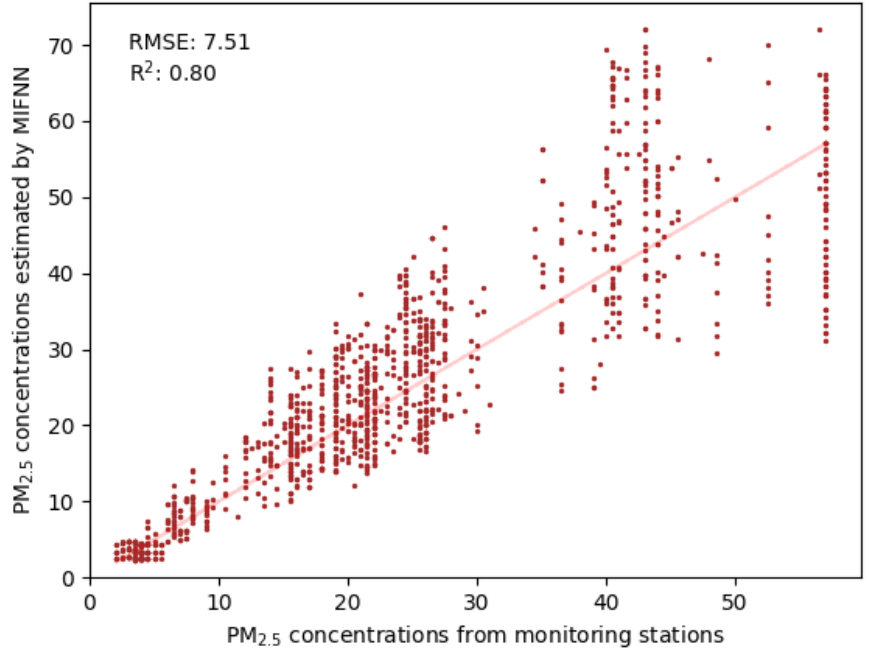
Figure 10. Correlation between PM 2.5 concentrations measured by ground-based monitoring stations and those estimated by the MIFNN model. The red dashed line is the 1:1